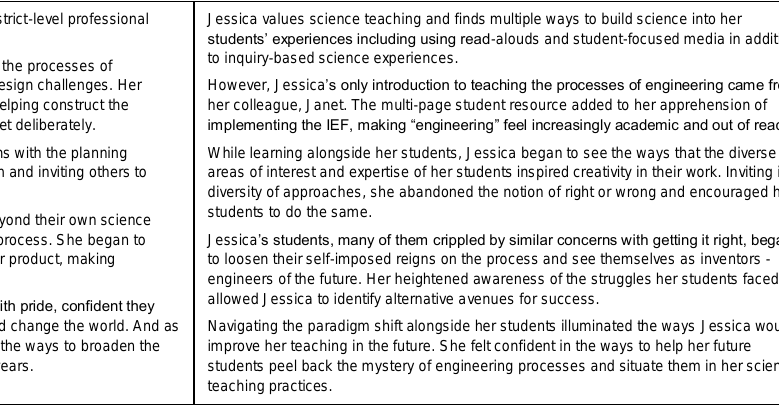
Table 3. Stories of